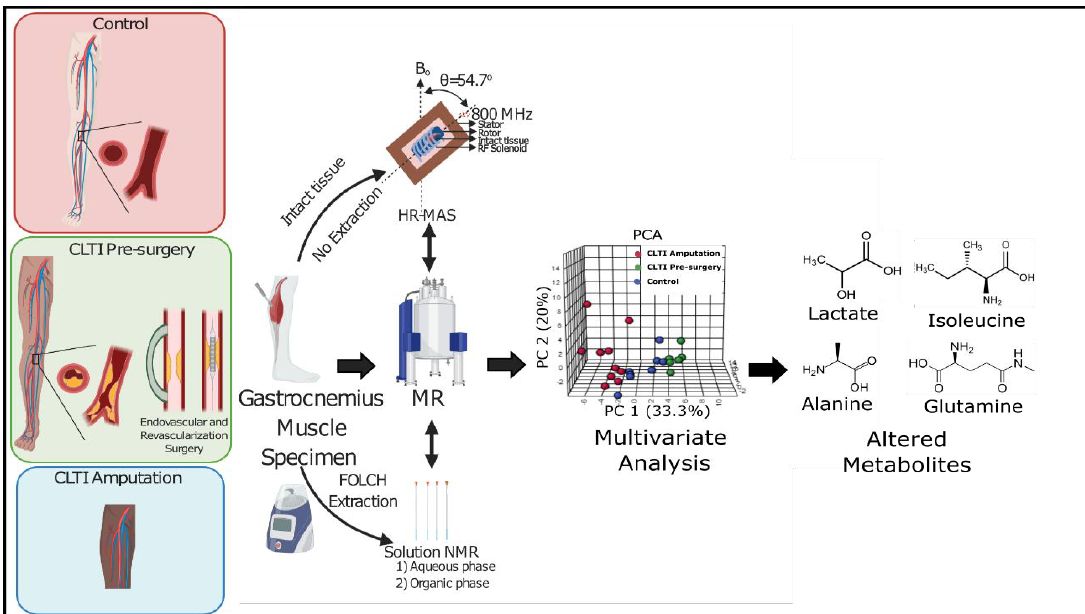
Figure 1. Graphical image showing the comprehensive workflow applied in this study, including gastrocnemius tissue collection from three different groups of patients (CLTI Amputation, CLTI Pre-surgery and healthy control), HR-MAS and solution state NMR spectra acquisition on those samples, multivariate analysis and identification of potential biomarkers. MR, magnetic resonance; and PCA, principle component analysis.